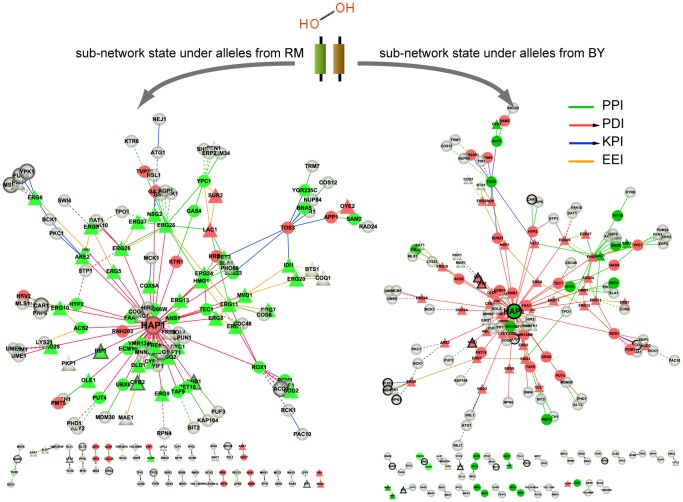
The state of the sub-networks in response to hydrogen peroxide in segregants inherited alleles from RM and BY.Solid edges indicate correlated expression between proteins in one allele state, whereas that organization is lost in another allele state (dotted line). Edge colors represent diverse interaction types between proteins, whereas node colors represent changes in gene expression between wild and mutant groups; green denotes down-regulation and red denotes up-regulation. Triangle nodes present genes annotated in ‘ergosterol metabolic process’, ‘lipid biosynthetic process’, and ‘oxidation reduction’. Nodes with dark edges are known drug targets of hydrogen peroxide based on Stitch2 database.